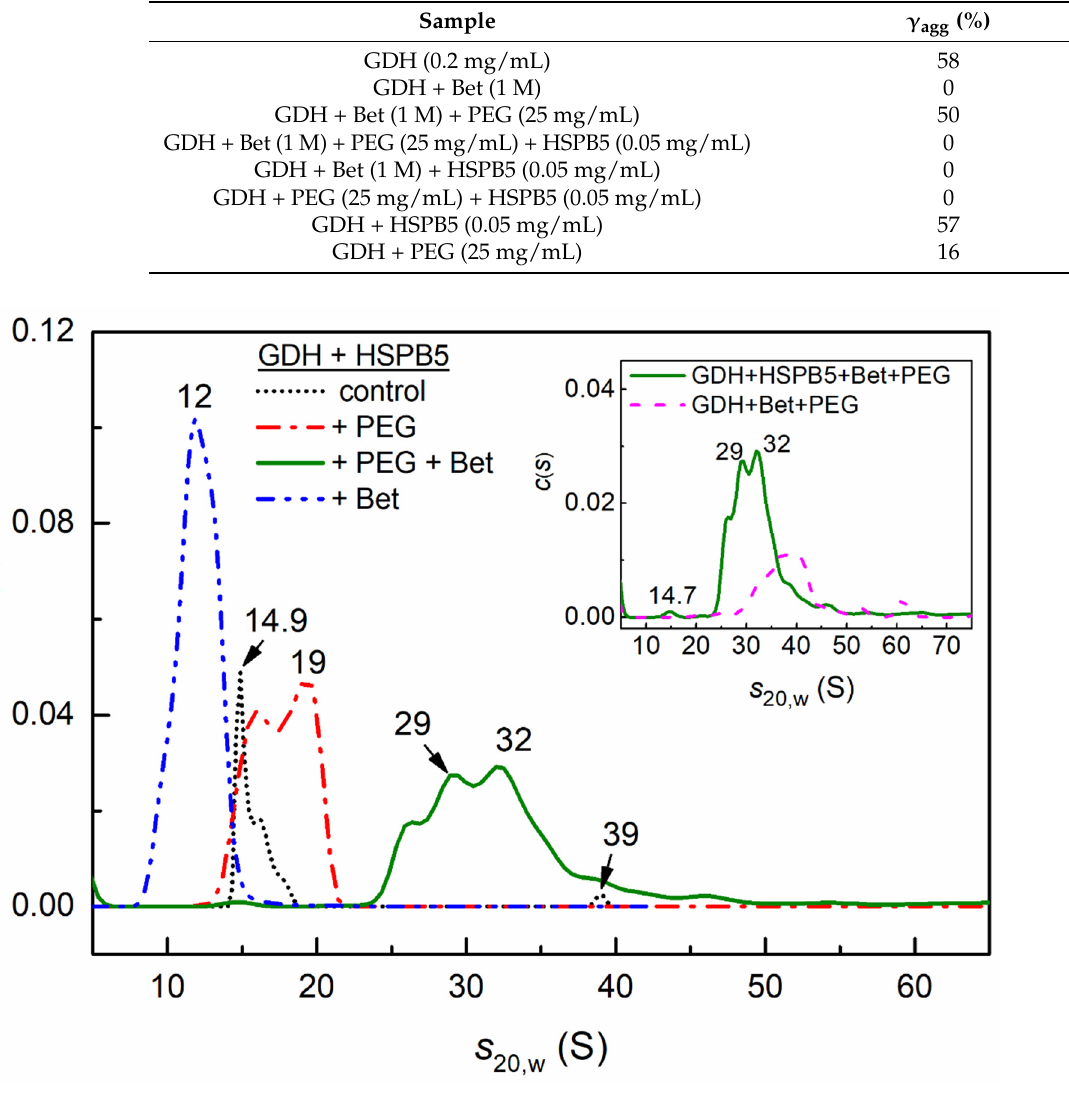
Figure 6. The sedimentation behavior of GDH (0.2 mg/mL, preheated 10 min at 50 °C) in the presence of 0.05 mg/mL HSPB5 at 25 °C. The differential sedimentation coefficient distributions, c ( s ), for the mixture of GDH and HSPB5 (black dotted curve) with the addition of 25 mg/mL PEG (red dash-dotted curve), 1 M Bet (blue dash-dot-dotted curve), and 25 mg/mL PEG + 1 M Bet (green solid curve). Inset shows c ( s ) distributions for GDH (0.2 mg/mL, preheated 10 min at 50 °C) in the presence of 25 mg/mL PEG + 1 M Bet (green solid curve) with the addition of 0.05 mg/mL HSPB5 (magenta dashed curve). All distributions were obtained at 25 °C and transformed to standard conditions. The rotor speed was 48,000 rpm.